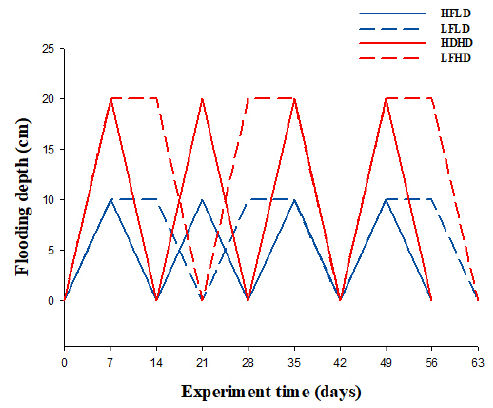
Figure 2. Experiment period.